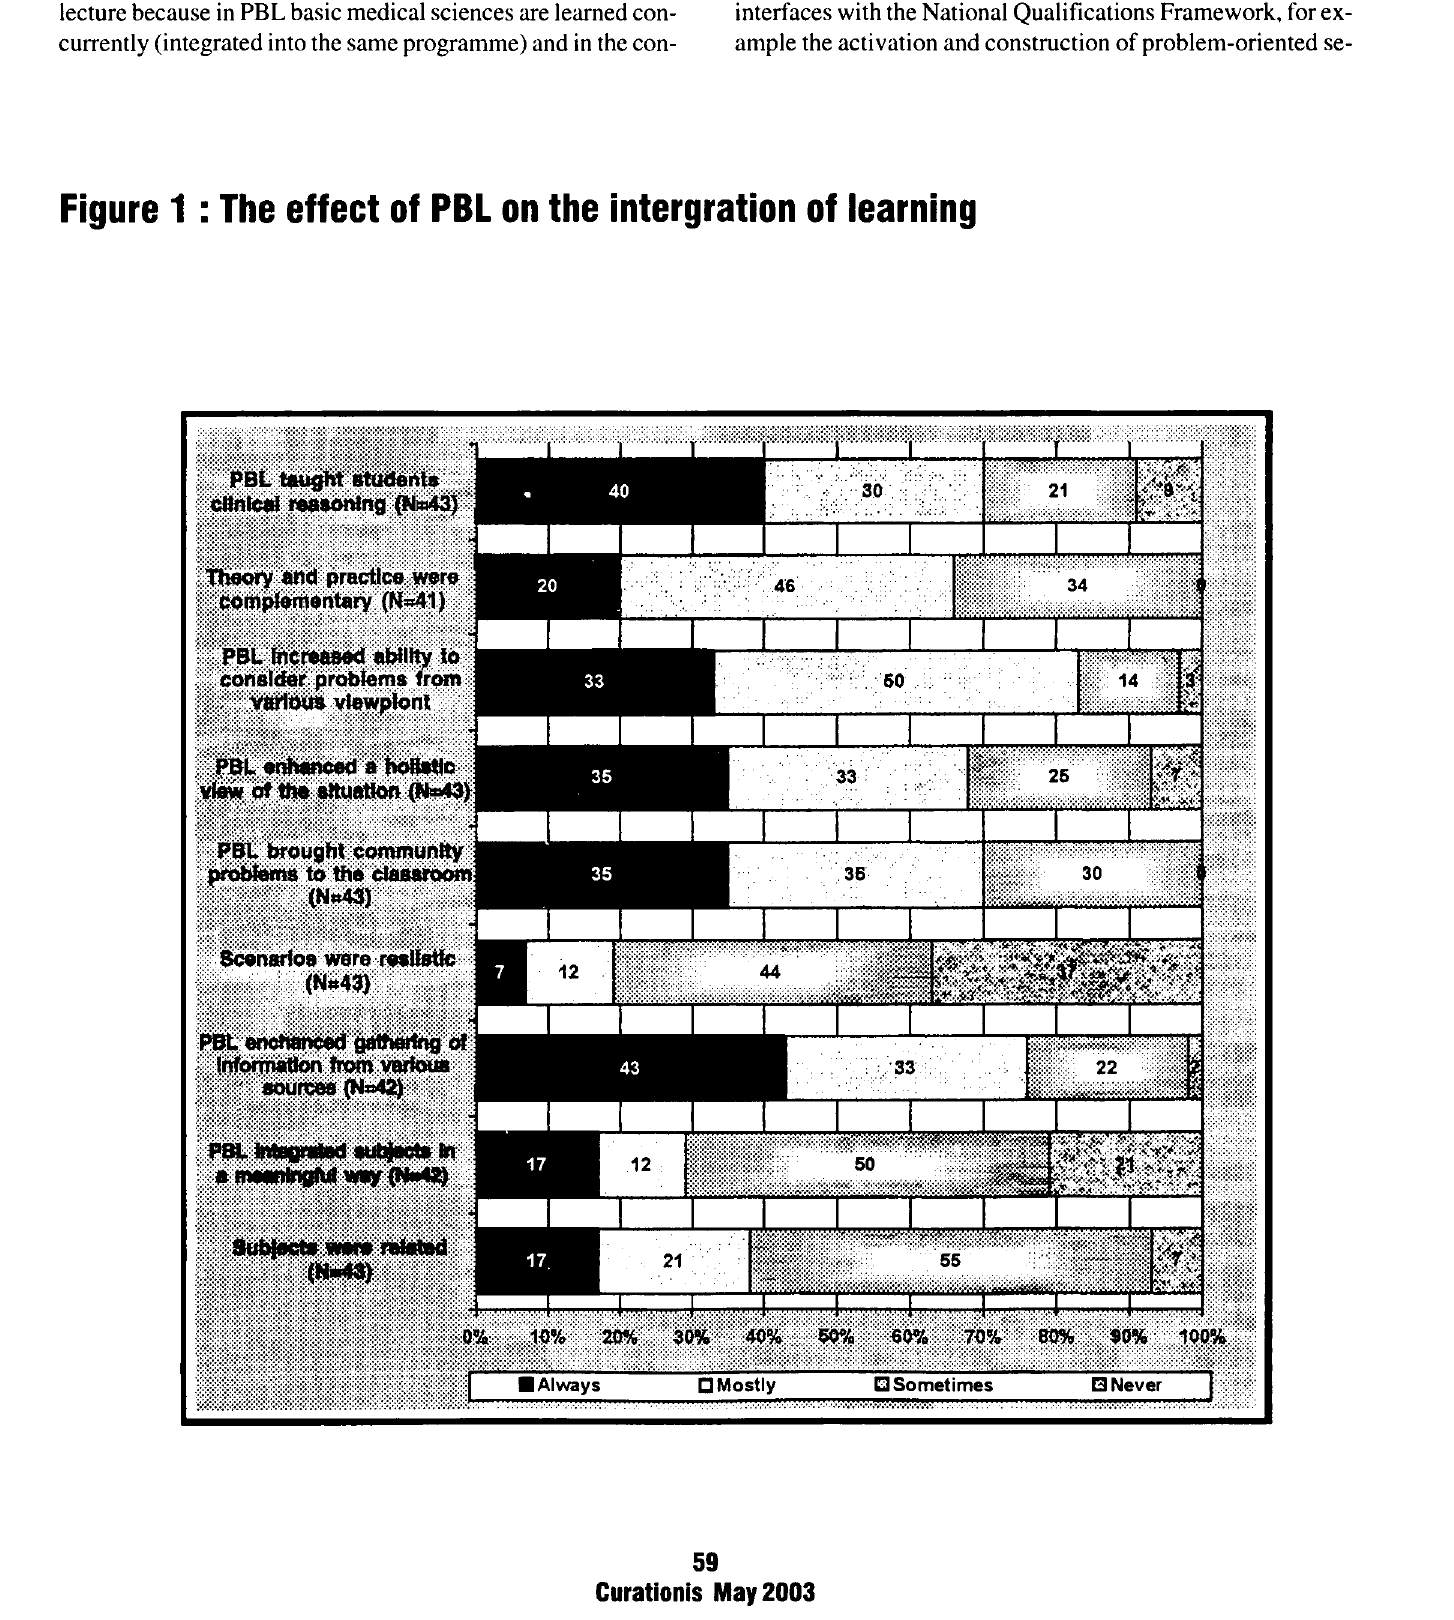
Figure 1 : The effect of PBL on the intergration of learning